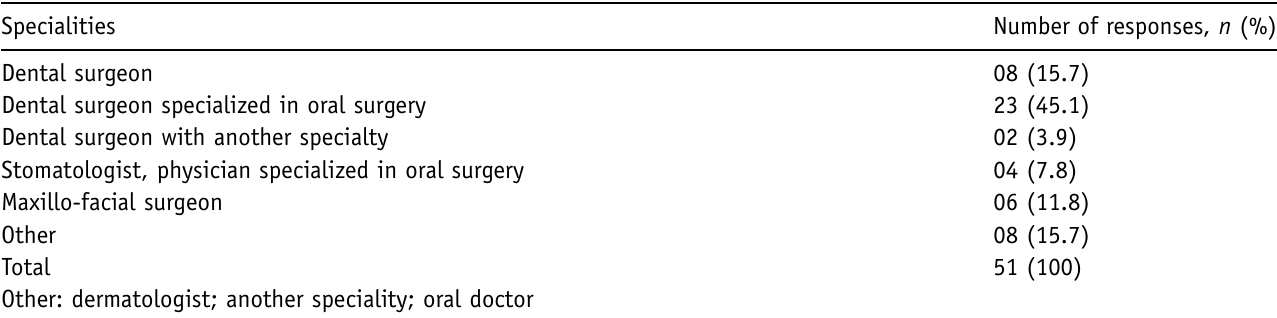
Table I. Number and proportion of responses by medical specialty.